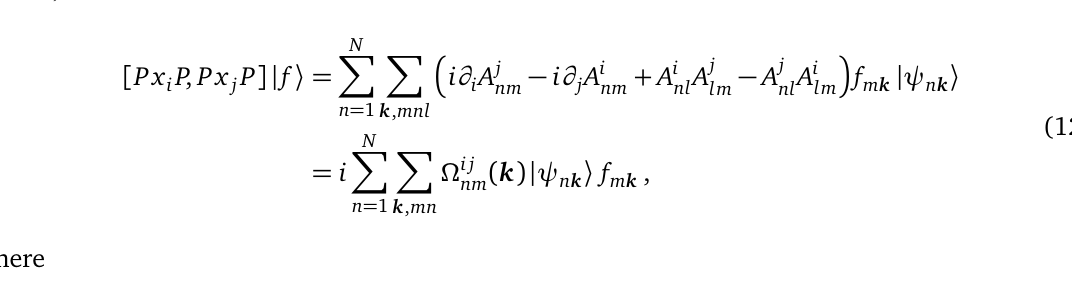
= ∪ considered as closed manifold for the defini- M M 1 M 2